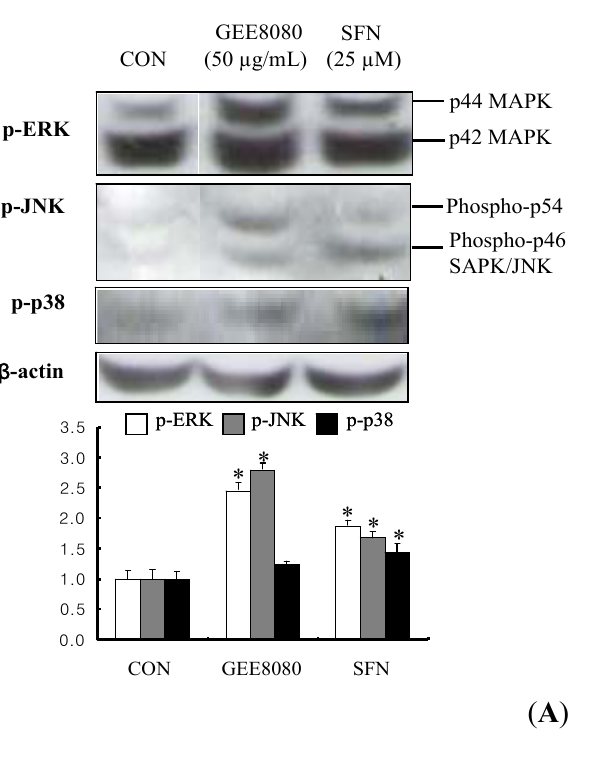
Figure 5. Effects of ginger extracts on the phosphorylations of upstream targets in HepG2 cells. ( A ) Effect of ginger extracts on phosphorylation of MAPKs and Akt. HepG2 cells were treated with 50 µg/mL ginger extracts for 1 h; ( B ) Influence of MAPK inhibitors on GEE8080-induced Nrf2 and HO-1 expression. HepG2 cells pretreated with vehicle or 50 μ M U0126 (MEK1/2 inhibitor), SP600125 (JNK inhibitor), SB202190 (p38 inhibitor), and LY294002 (Akt inhibitor) for 1 h prior to treatment with 50 μ g/mL GEE8080 for 1